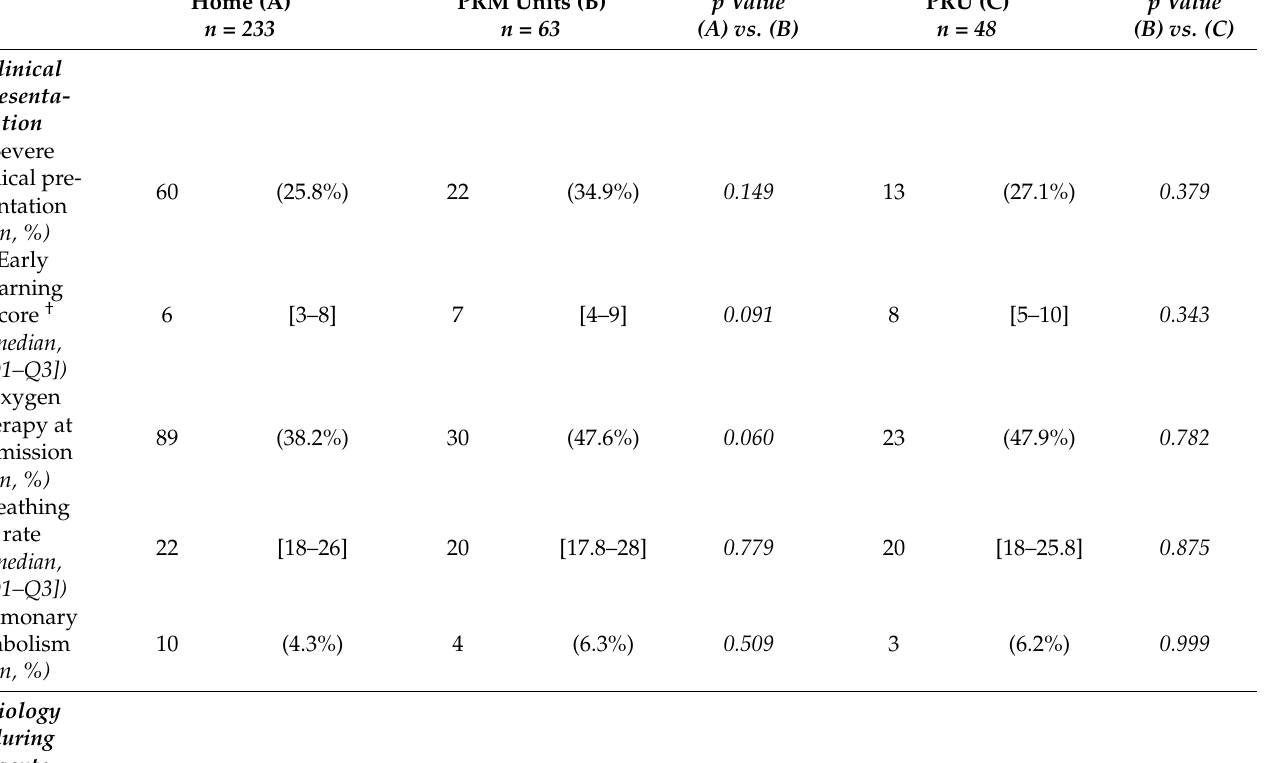
Table 2. Clinical presentation, biology results, and treatment of patients according to